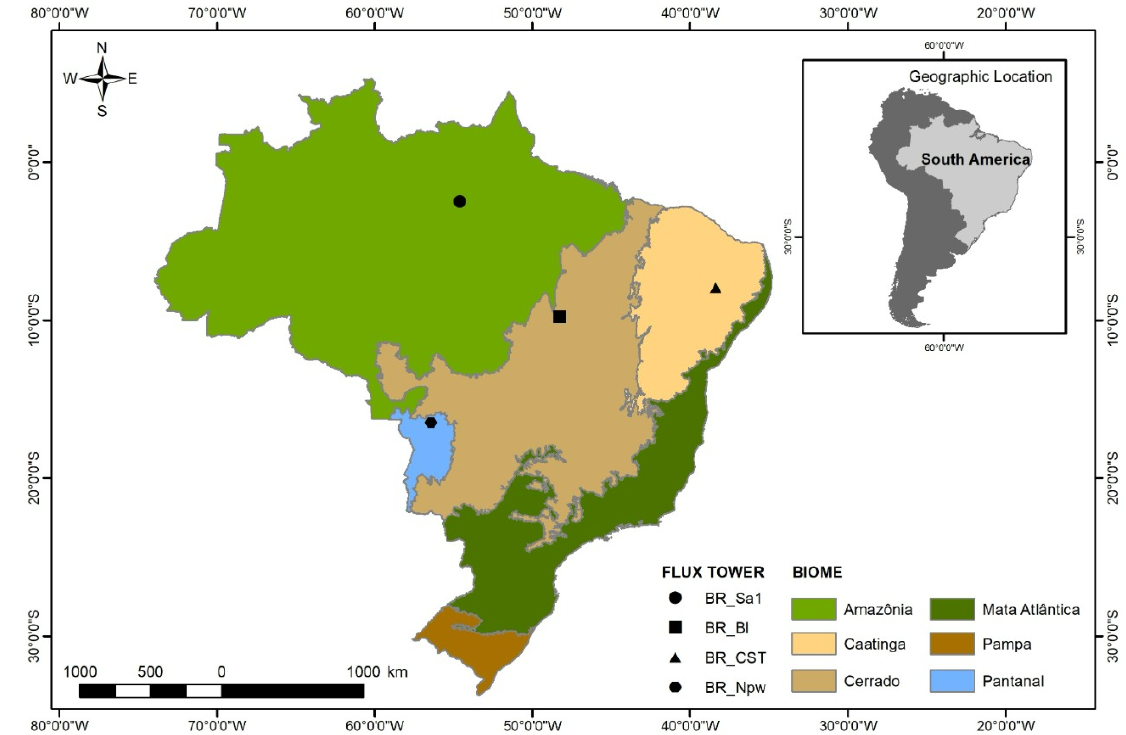
Figure 1. Location of the study sites with the native extension of each